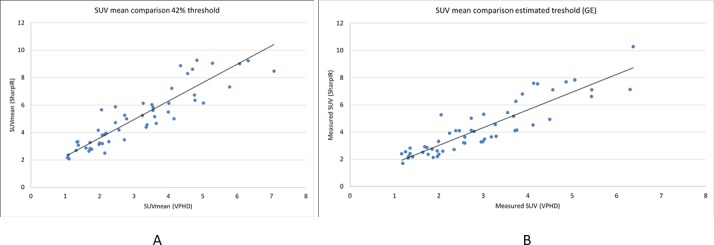
Diagrams of SUVmean with 42% threshold and estimated threshold.(A) SUVmean plotted for all lesions in VPHD and SharpIR clinical ACE-PET/CT, where ROIs are delineated with 42% threshold algorithm, and (B) estimated threshold algorithm. The black line is the best fit regression line.